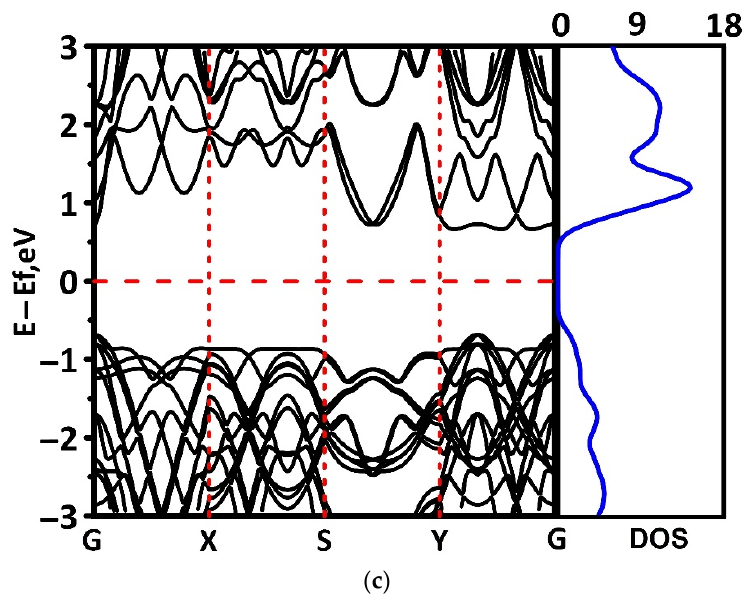
Figure 2. Band structure and DOS of van der Waals ZnO/BlueP/ZnO heterostructure with AAA ( a ), ABA ( b ), and ABC ( c ) stacking configurations.